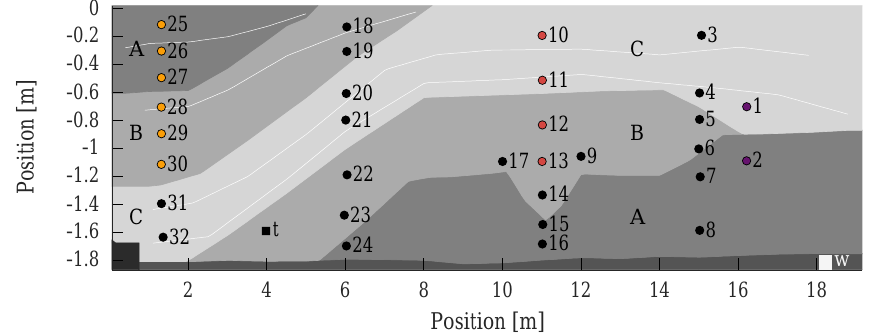
Figure 2. ASSESS features an effective 2-D architecture with three different kinds of sand (A, B, and C). The hydraulic state can be manip- ulated with a groundwater well (white square, at 18 . 2m) and is automatically monitored with 32 TDR sensors (dots) and one tensiometer (black square, at 4 . 0m). The color of the dots associates some of the TDR sensors with different cases of the 1-D study discussed in Sect. 3.1. The gravel layer at the bottom of the site ensures a rapid water pressure distribution over the site. An L element (black polygon, at 0 . 4m) and compaction interfaces (white lines) were introduced during the construction. Note the different scales on the horizontal and vertical axes.